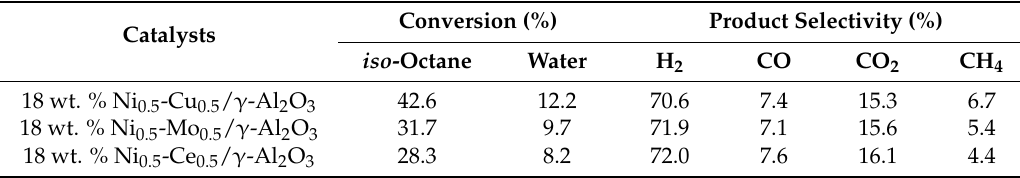
Table 3. Conversion and product selectivity for steam reforming of iso -octane on Al 2 O 3 supported